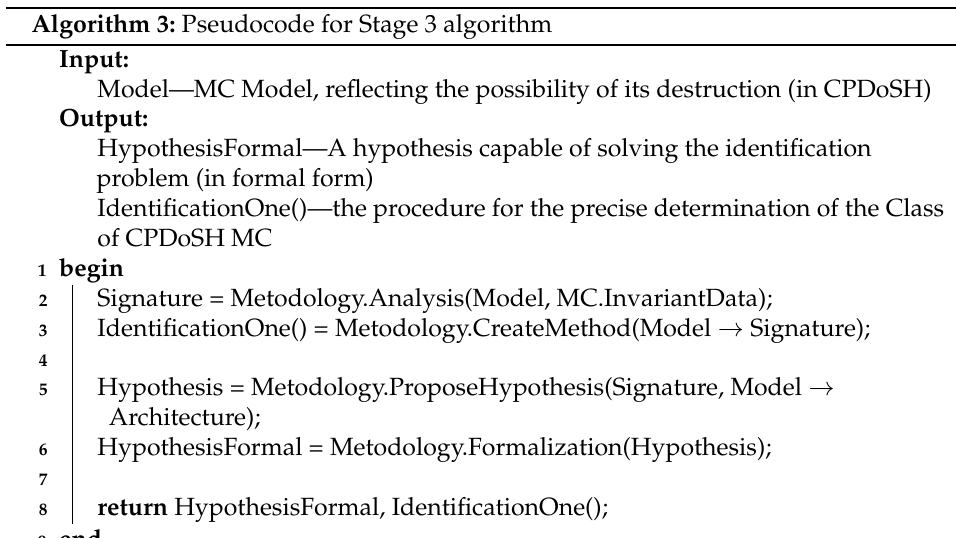
Algorithm 3: Pseudocode for Stage 3